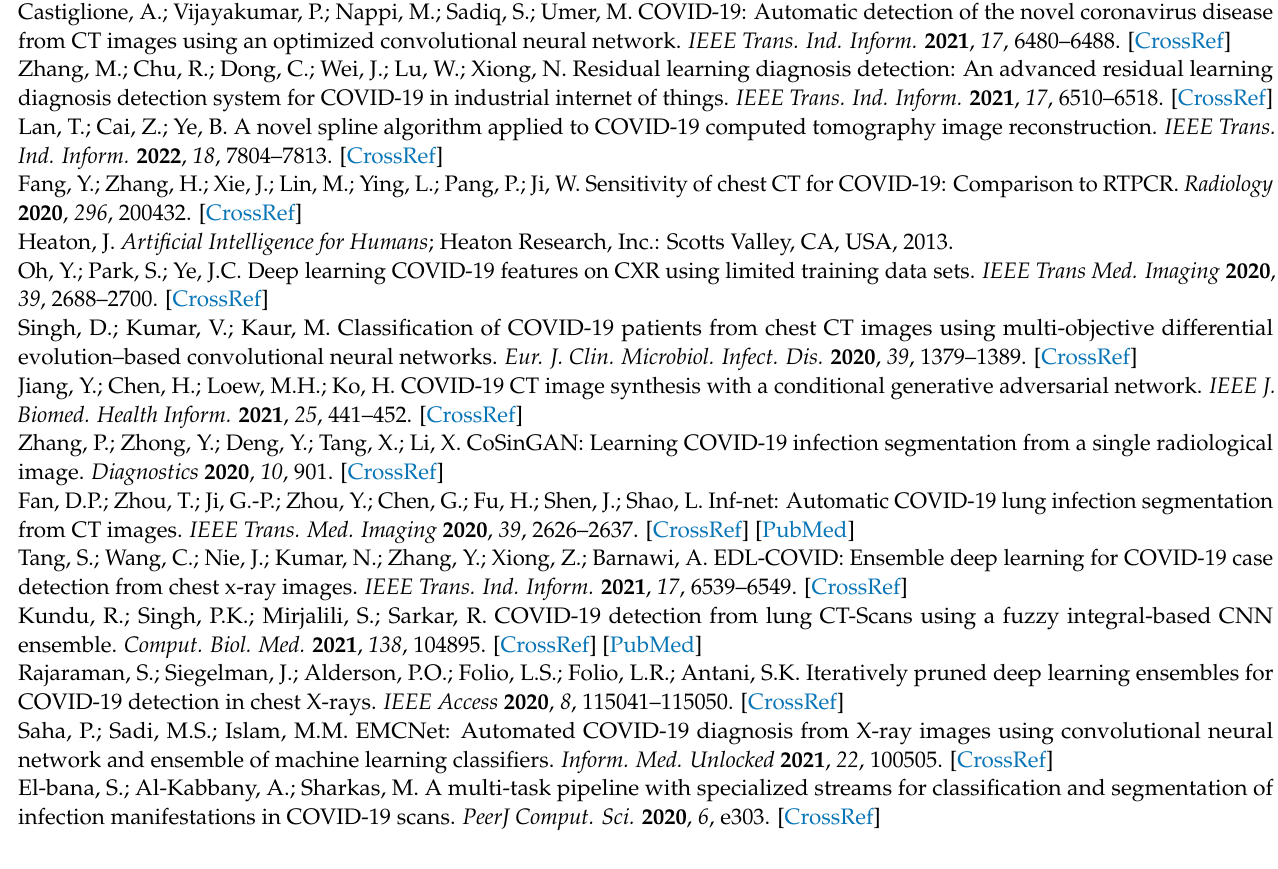
Figure 8. Illustration of misclassified (false positives and false negatives) testing samples, including prediction scores.